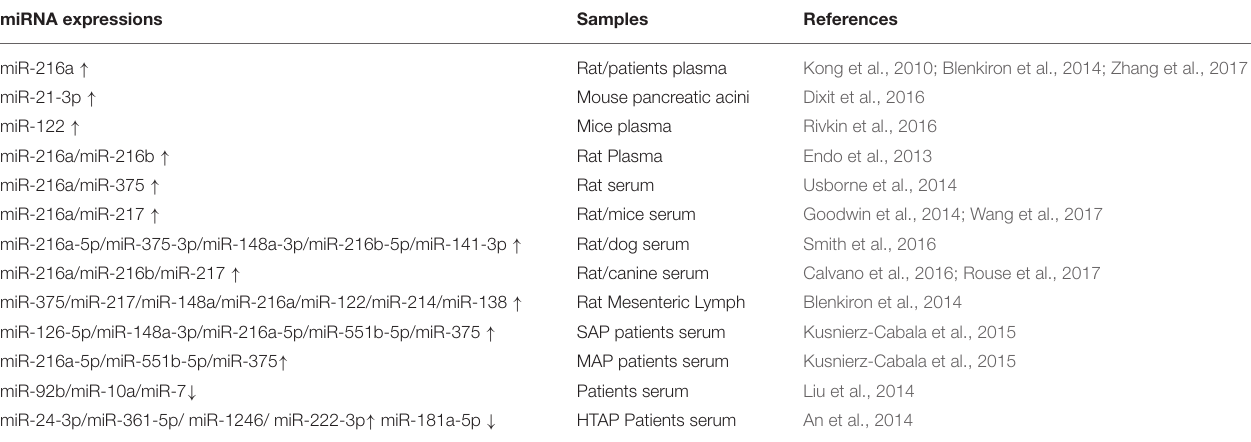
TABLE 1 | Aberrant miRNA expression levels in acute